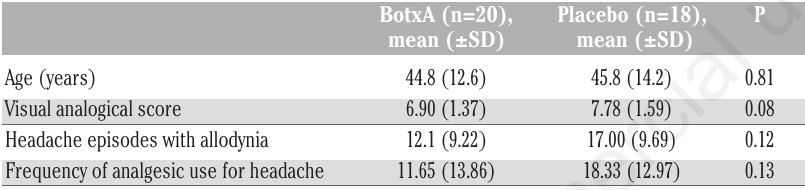
Table 2. Baseline demographic characteristics of the studied population.